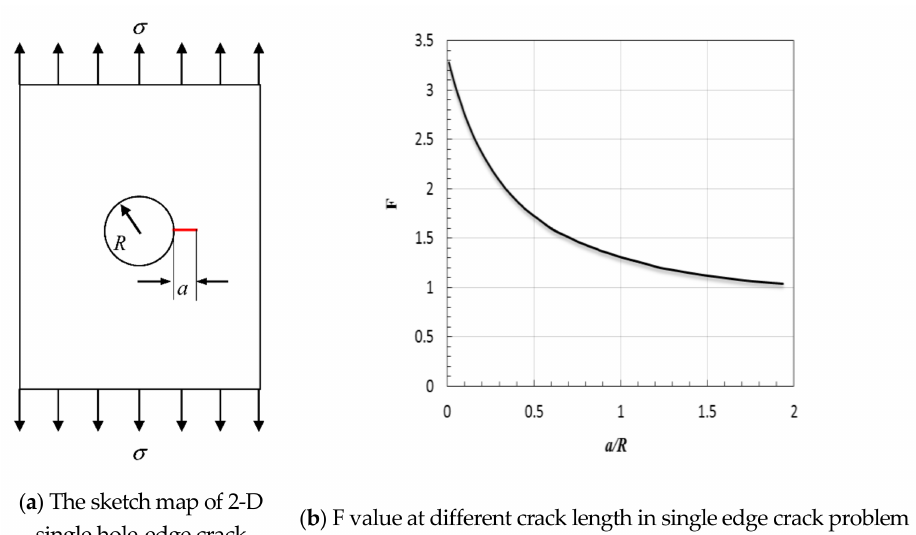
Figure 8. The standard 2-D crack growth problem.